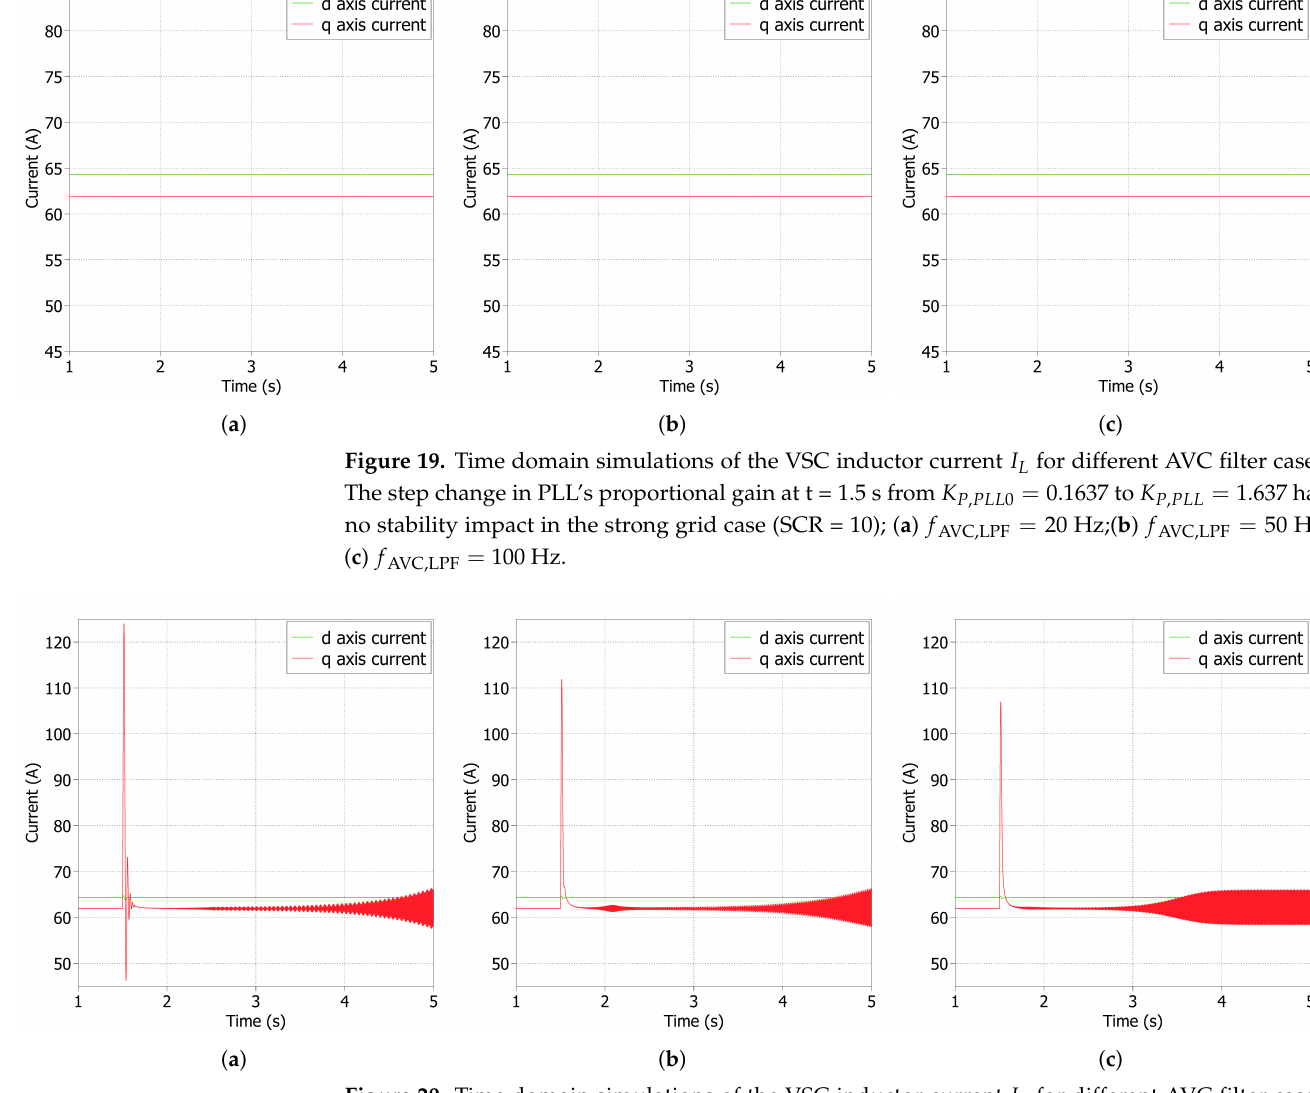
Figure 20. Time domain simulations of the VSC inductor current I L for different AVC filter cases. The stability impact of AVC in a strong grid (SCR = 10) is observed, caused after the ramp change in K I , a 0 to its critical value K I , acr at t = 1.5 s; ( a ) K I , acr = 10200 when f AVC,LPF = 20 Hz; ( b ) K I , acr = 9300 when f AVC,LPF = 50 Hz; ( c ) K I , acr = 8400 when f AVC,LPF = 100